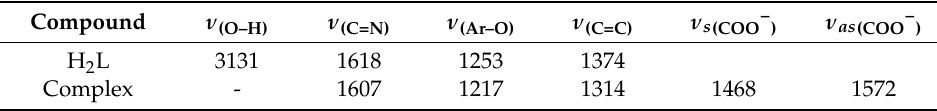
Table 2. The major IR spectra of H 2 L and its Zn II –Eu III complex (cm − 1